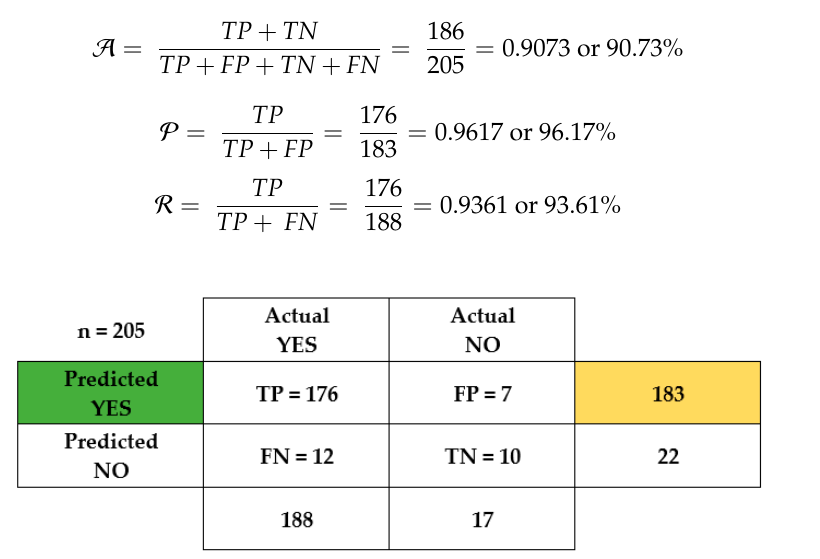
Figure 10. Confusion matrix of the algorithm of the Threat Identification Module (TIM).